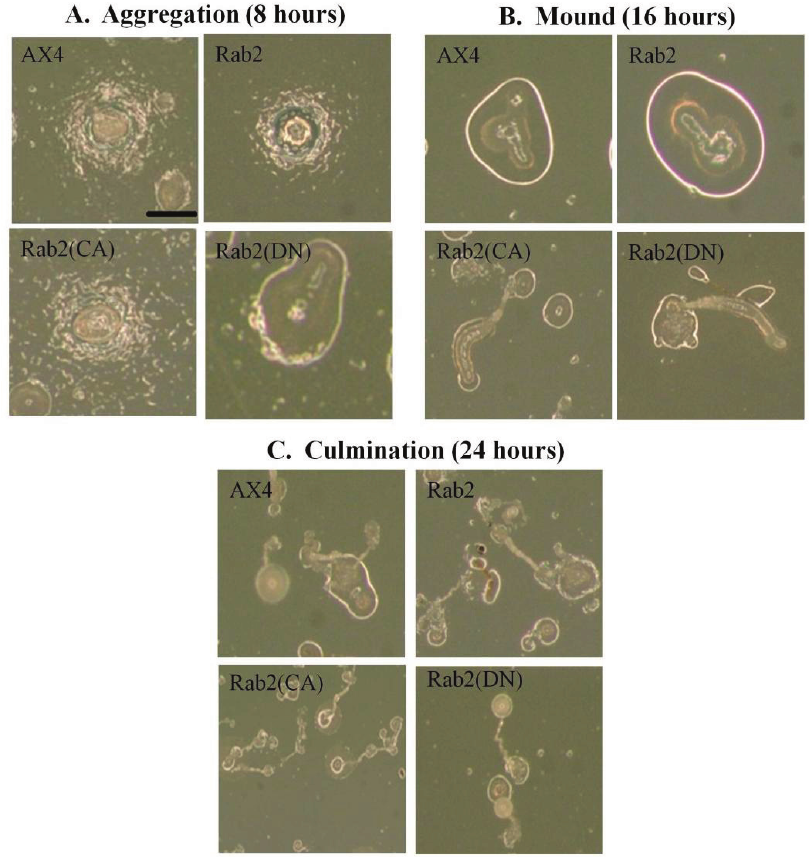
Figure 4. Over-expressing mutant forms of DdRab2 has an effect on the developmental process. ( A ) Representative photomicrographs of aggregation after 8 h of incubation at 22 °C on KK2 agar plates. Loose aggregates are visible in the AX4, Rab2, and Rab2(CA) cell lines after 8 h while the Rab2(DN) cells had already aggregated and formed a mound after 8 h; ( B ) Representative photomicrographs of mound formation after 16 h. After 16 h, wild type AX4, and Rab2 over-expressing cells show normal mound formation. Rab2(CA) cells have formed elongated mound structures. Rab2(DN) cells appear to have already formed fruiting bodies after 16 h; ( C ) Representative photomicrographs of fruiting body formation after 24 h. WT-AX4 and Rab2 over-expressing cell lines developed into fruiting bodies in the absence of nutrition after 24 h. Rab2(CA) and Rab2(DN) cell lines had formed fruiting bodies after 16 h and were still present after 24 h. The Rab2(CA) cell line appears to have formed a larger number of fruiting bodies that were smaller in size. Scale Bar: 1